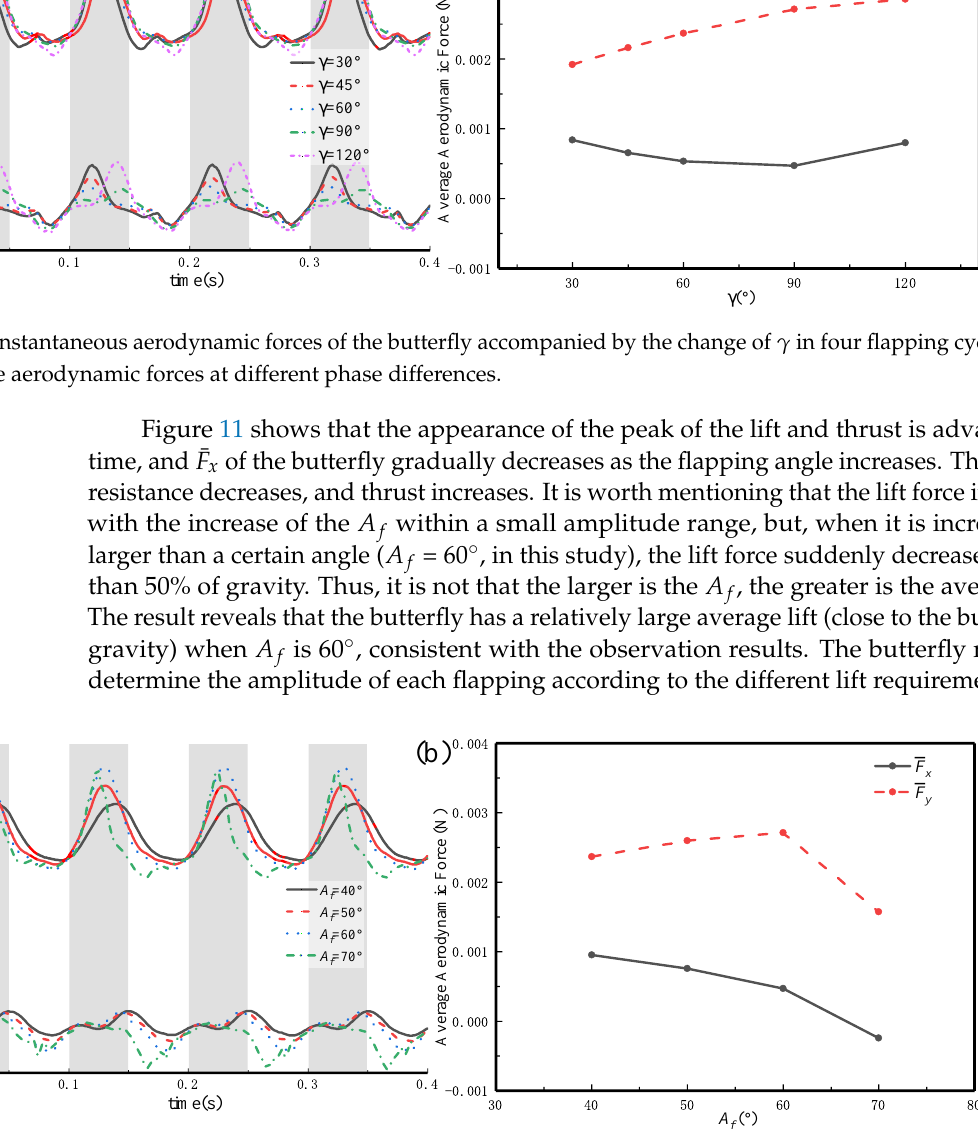
Figure 11. ( a ) The instantaneous aerodynamic forces of the butterfly accompanied by the change of A f in four flapping cycles; and ( b ) the average aerodynamic forces at different amplitude of flapping